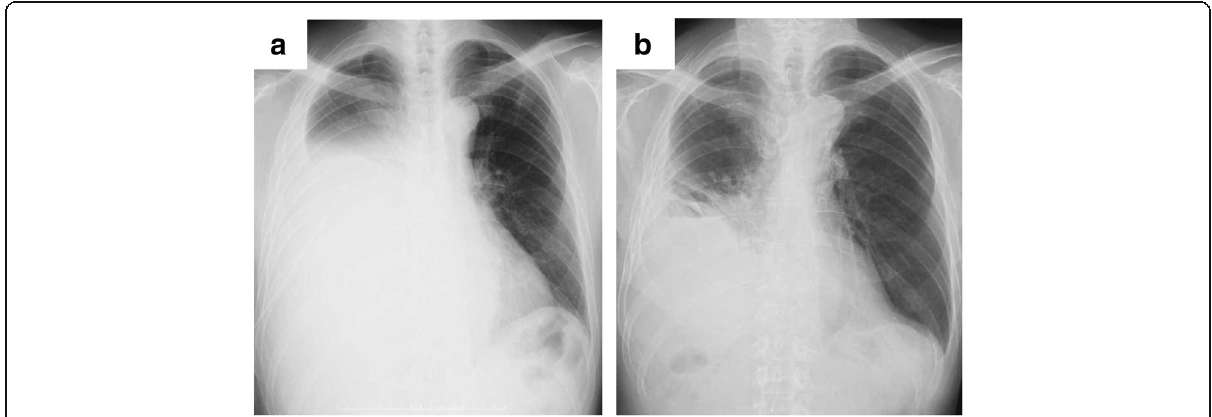
Fig. 1 a Chest roentgenogram at presentation showing right pleural effusion. b Chest roentgenogram 2 months after right pleurectomy/